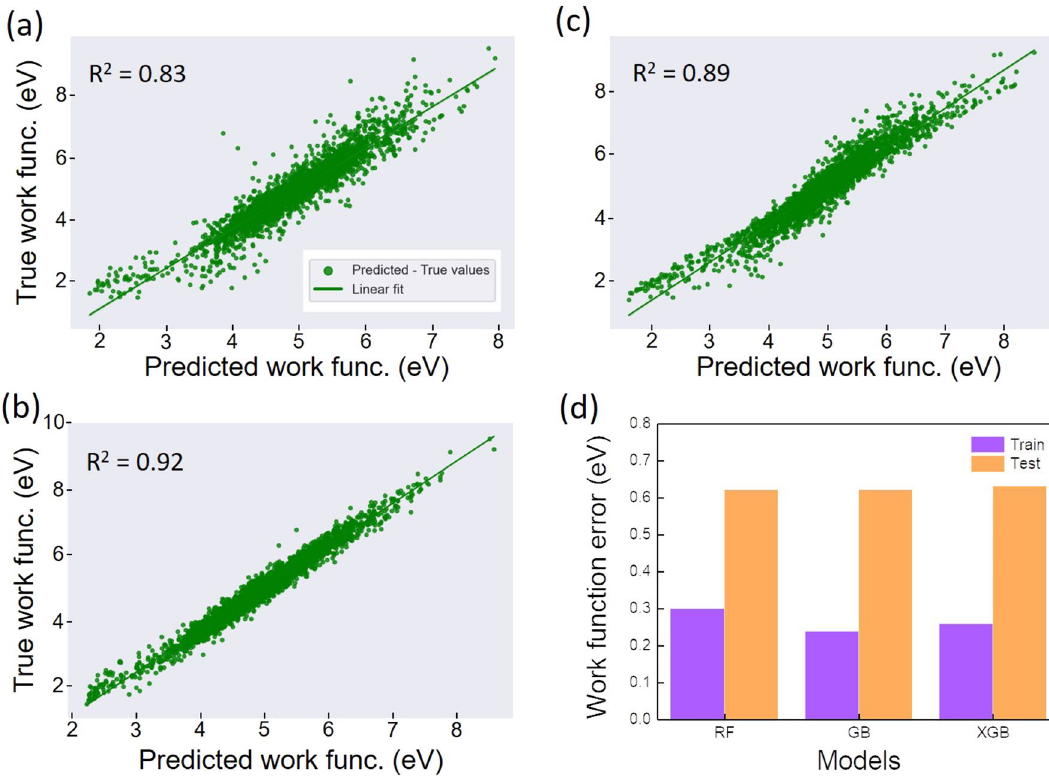
Figure 4. ML prediction of the work function with the feature set 1. Visualization of the predicted and true values of the work function (training set) obtained with RF, GB, XGB models ( a , b , c ). Bar plot shows the MAE errors of the training and test sets ( d